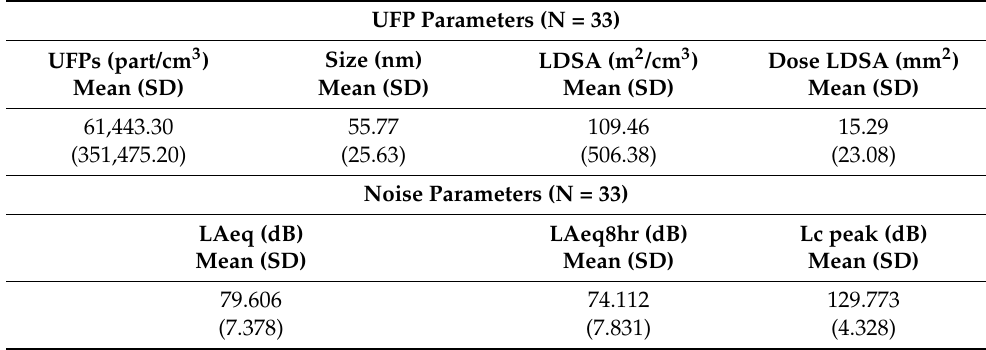
Table 1. Ultrafine particle (UFP) and noise exposure parameters in the overall sample of 33 participants. UFP Parameters (N = 33) UFPs (part/cm 3